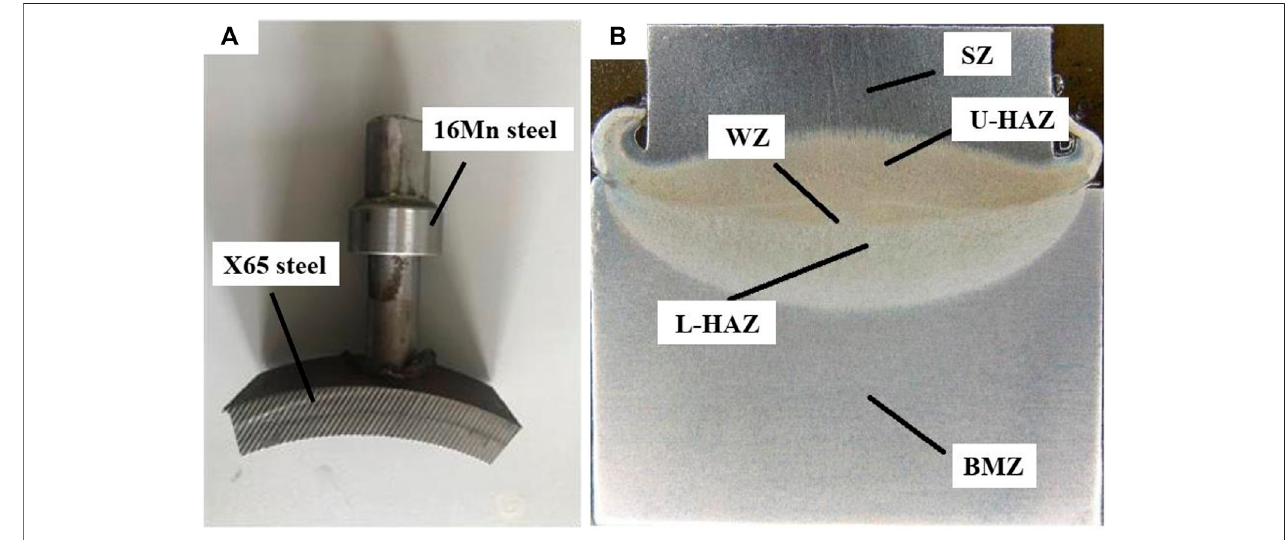
FIGURE 1 | FSW weldment (A) and joint cross-sectional morphology (B) .